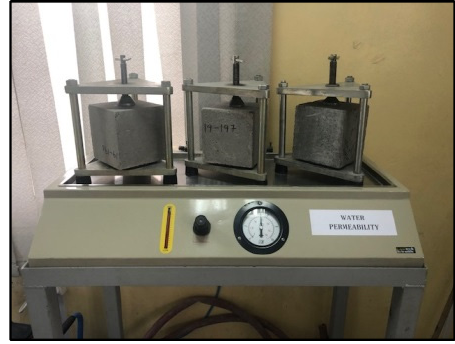
Figure 6. Water permeability test device.